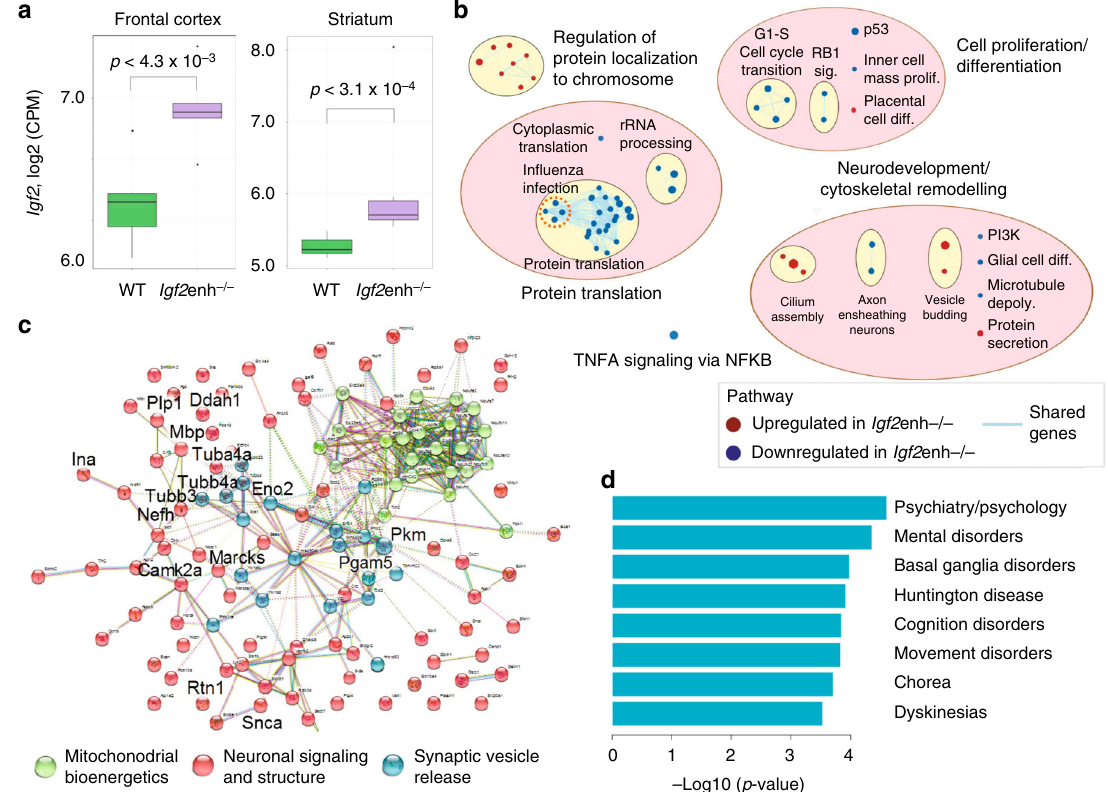
Fig. 4 Transcriptomic and synaptic proteome alterations in the brain of mice lacking the enhancer at Igf2. a Transcript levels of Igf2 in the frontal cortex and striatum of adult wild-type and Igf2 enh − / − mice. Left: frontal cortex (green boxplots: n = 6 wild-type, purple boxplots: 6 Igf2 enh − / − mice). Right: striatum ( n = 7 wild-type mice, 8 Igf2 enh − / − mice). P -values from two-sided Wilcoxon test. Boxplot center indicates median; box bounds indicate 25th and 75th percentile, and whiskers mark 1.5 times the interquartile range. b Pathways enriched for differential expression in the striatum of Igf2 enh-/- mice, relative to wild-type mice. Nodes shows pathways with q < 0.05 (68 pathways, preranked GSEA) and edges indicate shared genes (EnrichmentMap 87 ; default setting of Jaccard and overlap = 0.375). Red nodes: upregulated expression in Igf2 enh − / − ; blue nodes: downregulated expression in Igf2 enh − / − mice. Pathways were clustered using AutoAnnotate 93 . Full pathway enrichment results in Supplementary Data 15. c Functional annotation of synaptic proteins signi fi cantly altered in the striatum of Igf2 enh − / − mice relative to wild-type mice ( q < 0.01; one-way ANOVA; n = 6 wild-type mice, 6 Igf2 enh − / − mice, 2 pools per genotype with 3 mice/pool). Genes overlapping synaptosomal proteome abnormalities in schizophrenia brain 36 are highlighted. Quantitative proteome analysis by mass spectrometry and clustering of top proteins altered in Igf2 enh − / − mice by STRING. Node fi lls